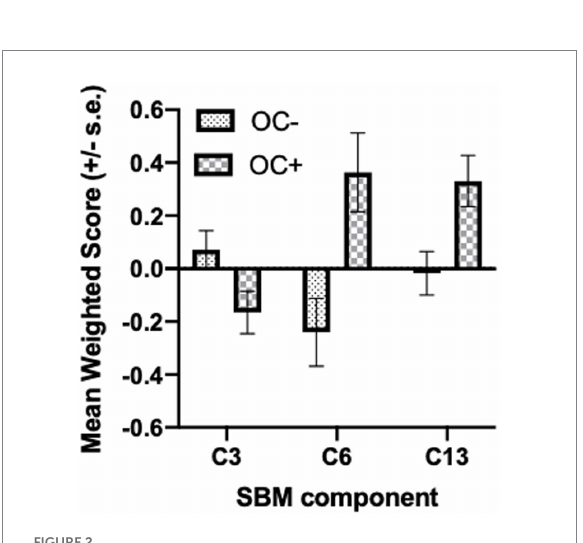
FIGURE 2 Mean SBM weighted score (+/ − s.e.) in OC − and OC+ apes for component 3, 6, and